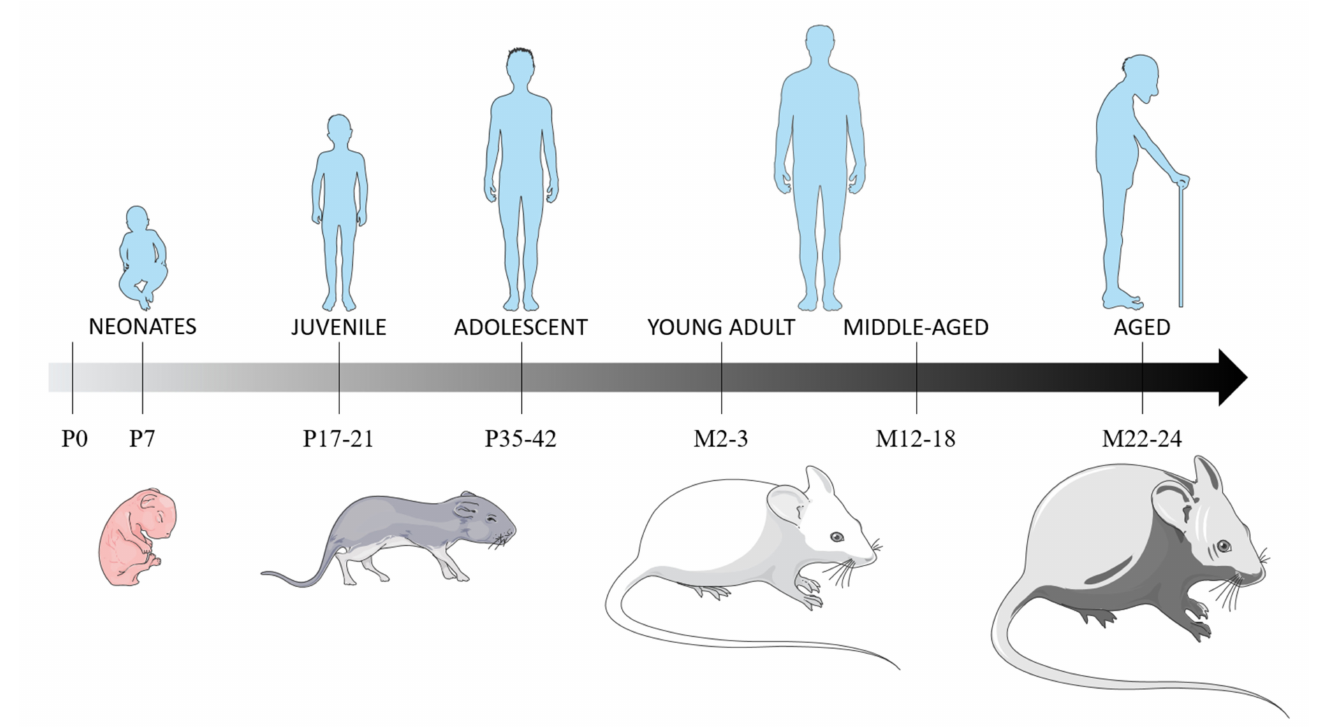
Figure 1. Rats’ and mice’ age correspondence with humans, based on brain and metabolism development, and sexual maturation. The brain developmental period occurs during the first three post-natal weeks, with the main brain growth- spurt period in the first post-natal week, a period of maximal neuronal proliferation, glial proliferation and the establishment of synaptic connections [132,133]. At P11, the neurological development in rodents is equivalent of a child below the age of 4 years [134]. Rodents can be considered juvenile at P17-21, based on equivalent synapse formation and γ -aminobutyric acid synthesis than in humans [135]. P35 rodents can be considered equivalent to preadolescent humans [136], as they will have developed 90% of their adult metabolic process [137] and as their sexual maturity is achieved at P60 [138]. Abbreviations: P: postnatal day; M: postnatal months